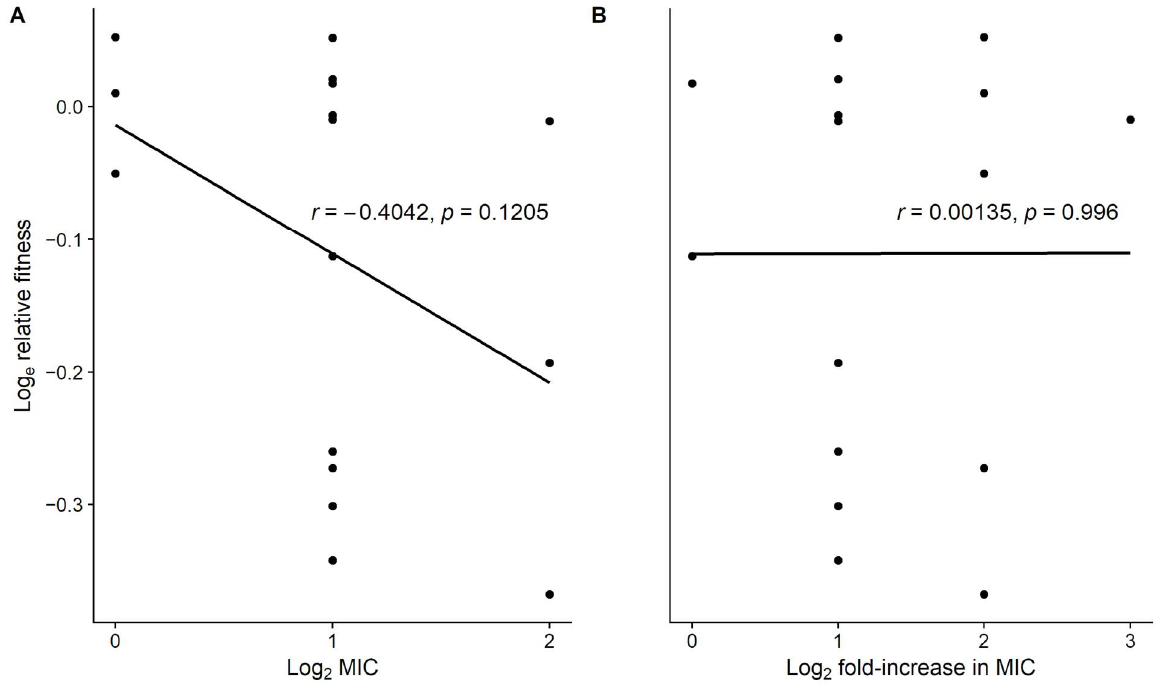
Figure 2. Variation in relative fitness of ampicillin-resistant mutants is not significantly correlated with their resistance level. Correlation between the mean log e -transformed fitness of 16 ampicillin- resistant mutants and their ( A ) log 2 -transformed minimum inhibitory concentration (MIC), and ( B ) log 2 -transformed increase in resistance relative to their parental clones after a single round of drug selection [16].